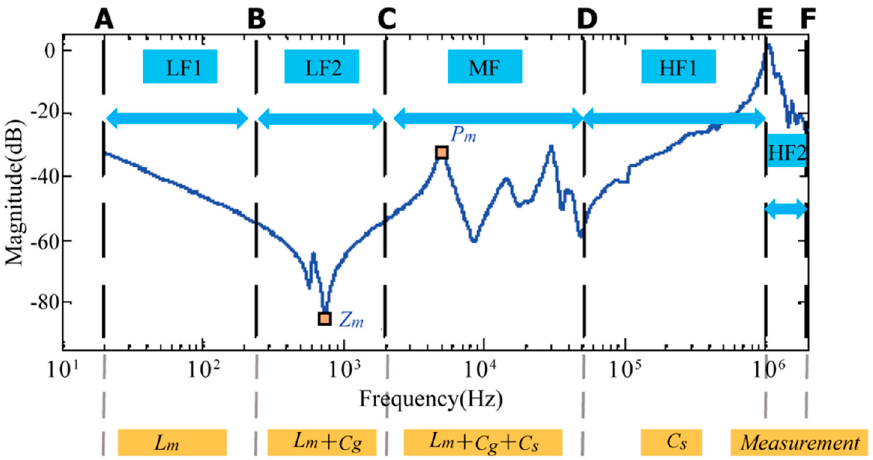
Figure 3. Illustration of a typical five-sub-band structure for a transformer winding.